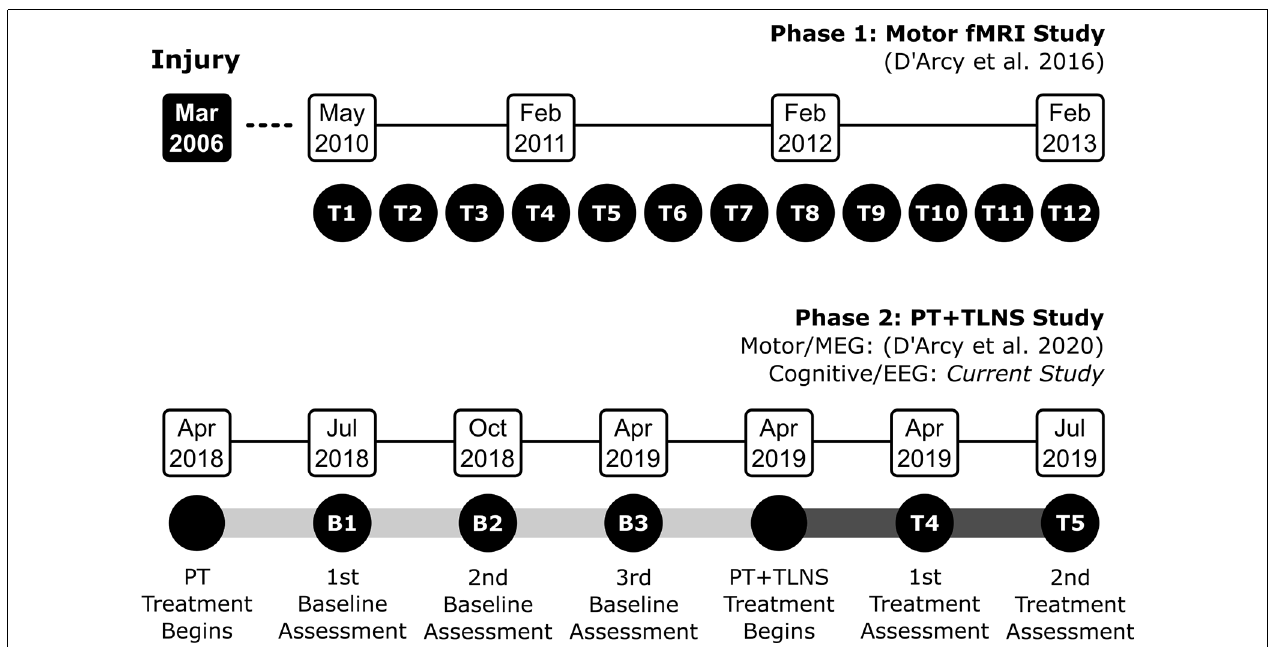
FIGURE 1 | Overview of the experimental design and clinical timelines for the overall and current studies (B: Baseline; and T: